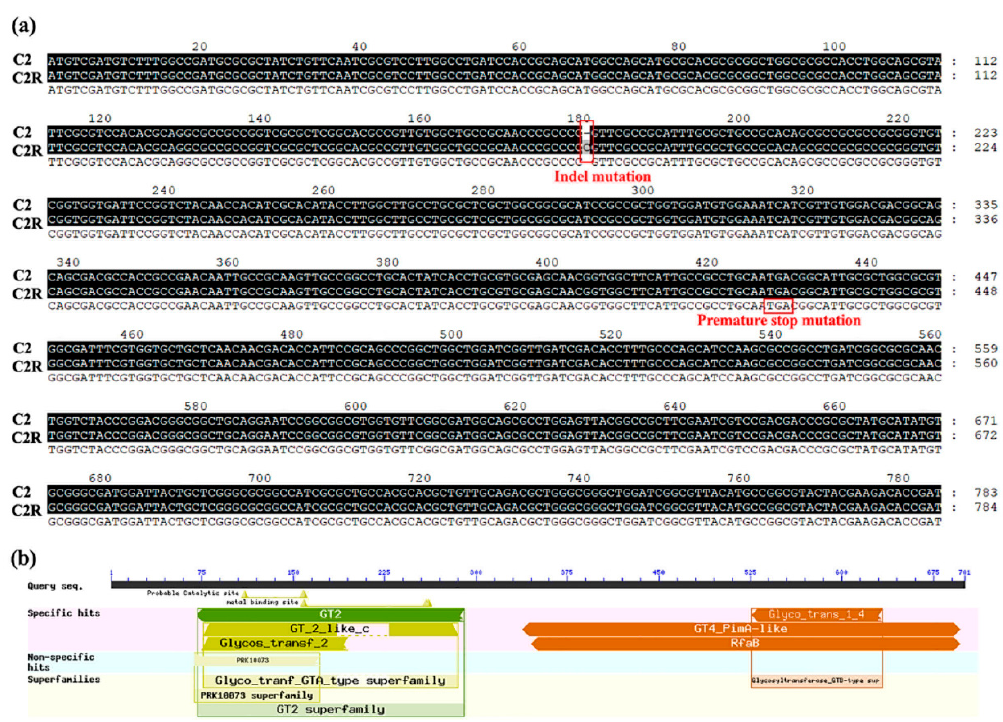
Figure 2. Information about the mutation site CDS2289 of phage-resistant mutant C2R of Xoo. ( a ) Frameshift mutation site and premature stop mutation in mutant C2R. ( b ) Annotation of CDS2289 protein.